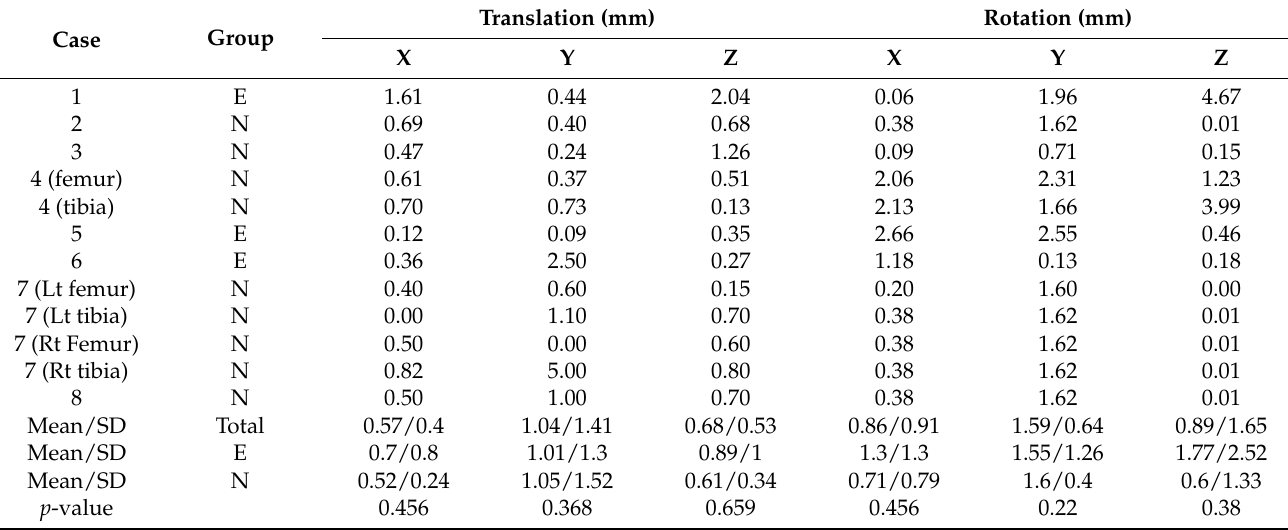
Table 2. Raw data of errors of translation and rotation in corrective osteotomy of eight